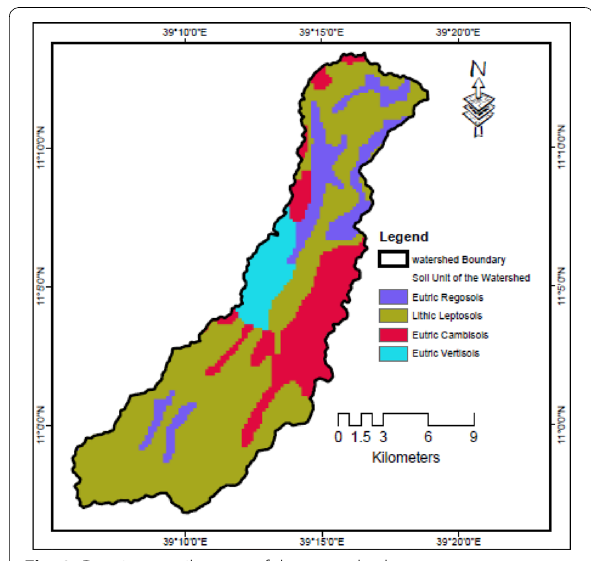
Fig. 8 Dominant soils types of the